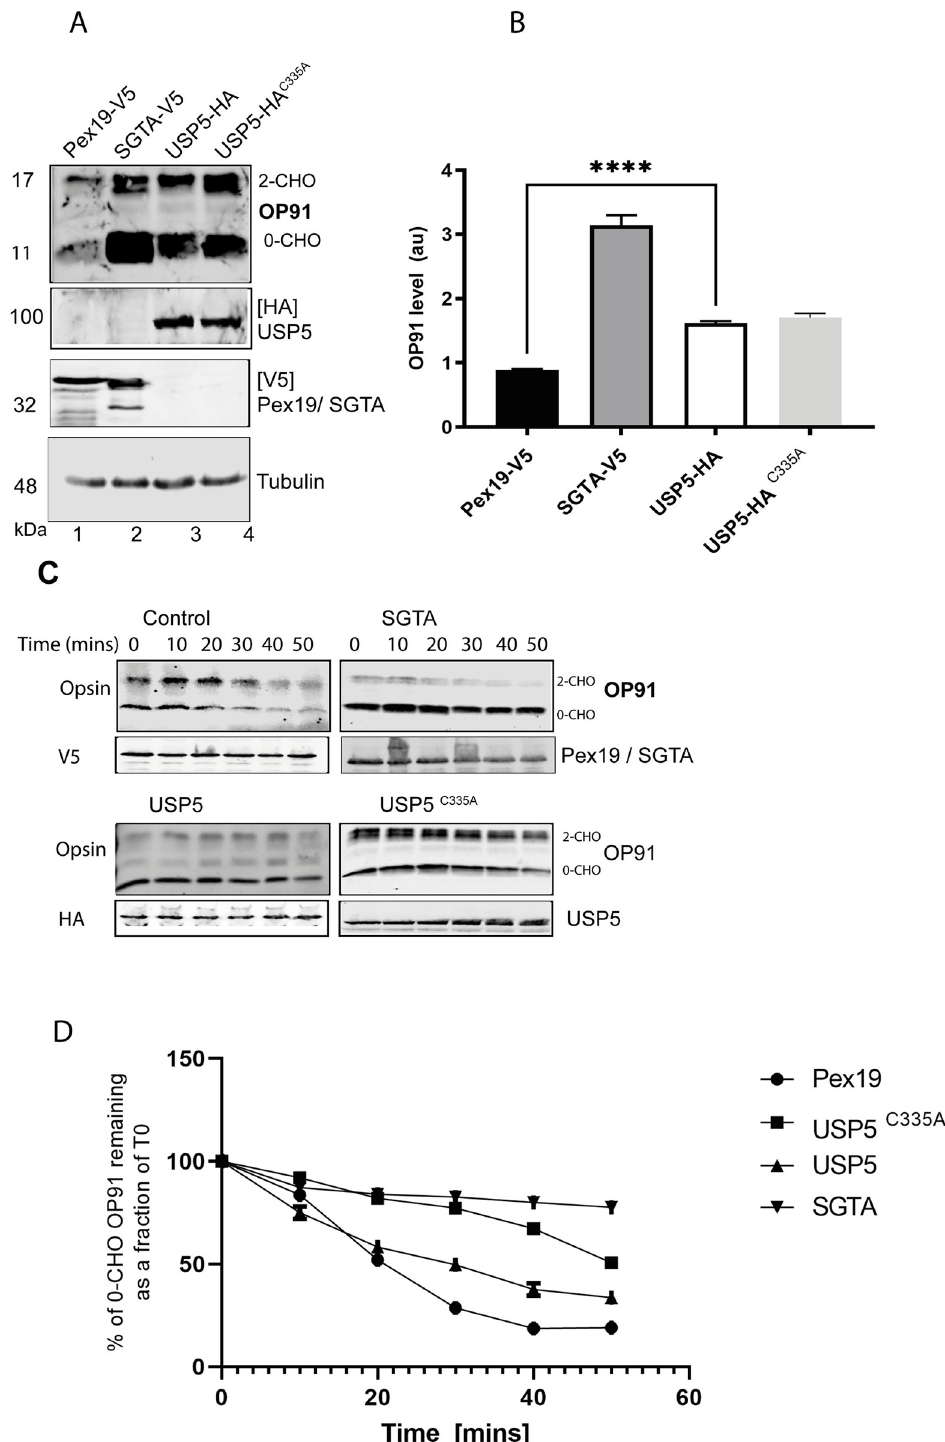
Fig 5. Overexpression of USP5 stabilises OP91. A) HeLa T-REx Flp-In cells stably expressing OP91 upon induction were transfected with V5-tagged Pex19 and SGTA or HA -tagged WT or C335A mutant of USP5. OP91 expression was induced 6 hours post-transfection. Cells were grown for a further 20 hours, post-induction. Total cell lysates were prepared and analysed by western blotting using antibodies against OP91, V5 tagged SGTA and Pex19, HA tagged USP5 and USP5 C335A and tubulin (loading control). B) OP91 signals were quantified using Odyssey 1 Fc Imaging